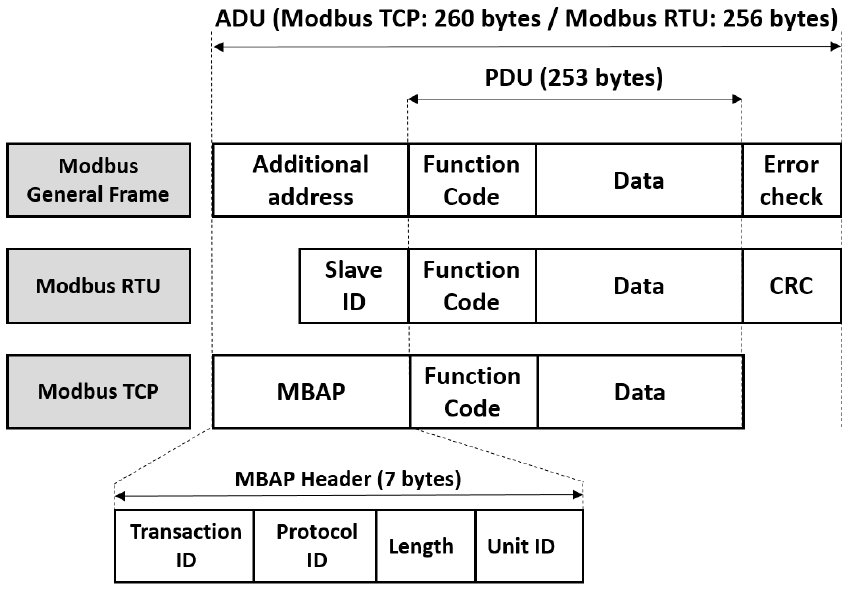
Figure 3. The Modbus frame [2].